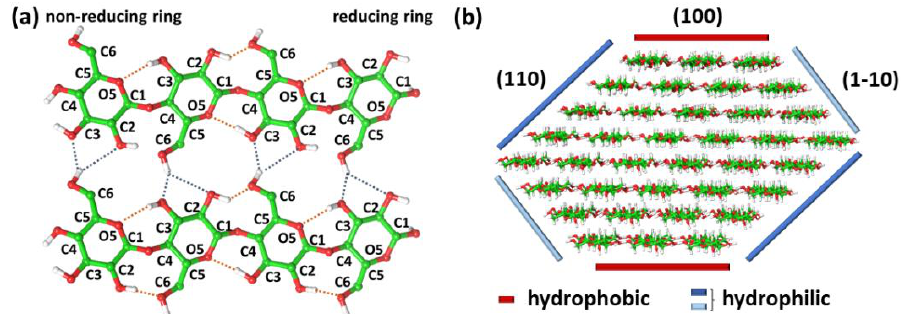
Figure 1. ( a ) Schematic representation of cellulose molecular structure and of the in-plane intrachain (orange) and interchain (dark blue) hydrogen bonds network responsible for the stable cellulose suprastructure. ( b ) Hydrophilic and hydrophobic surfaces of cellulose fibril, highlighting cellulose amphiphilic nature.